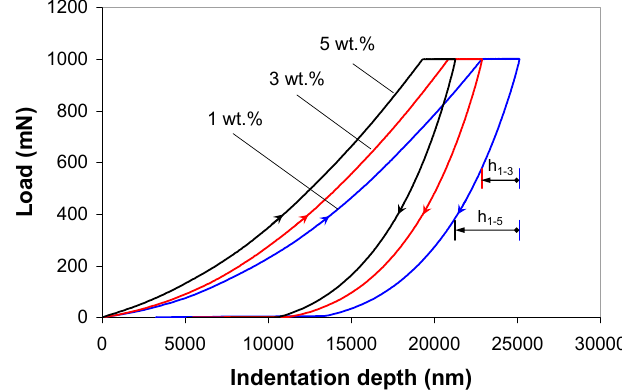
Figure 4. Experimental load-displacement response for 3-step indentation on the PP/MWCNT nanocomposites at 2000 mN/min loading/unloading rate and 40 s holding time.